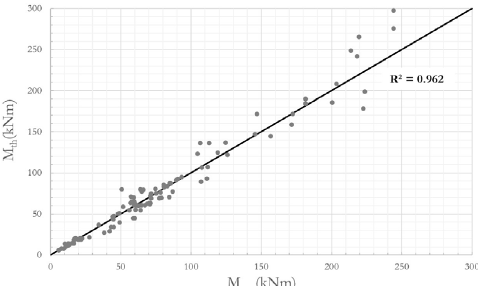
Figure 11 – Correlation scatter plot for the experimental M exp. and theoretical M th flexural capacities